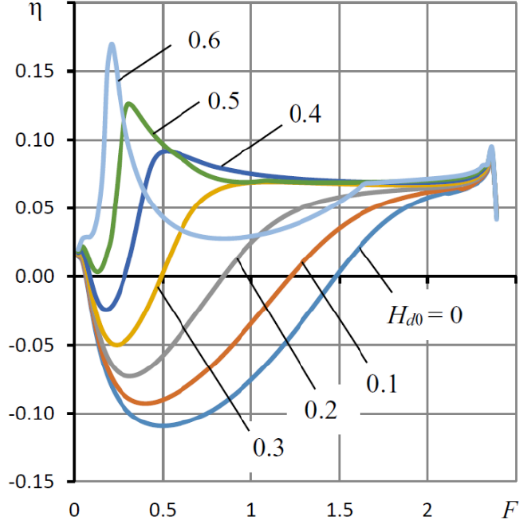
Figure 8. Graph of the dependence of the stability degree η on the load F at different values of H d 0 , σ = 25, V k =16.